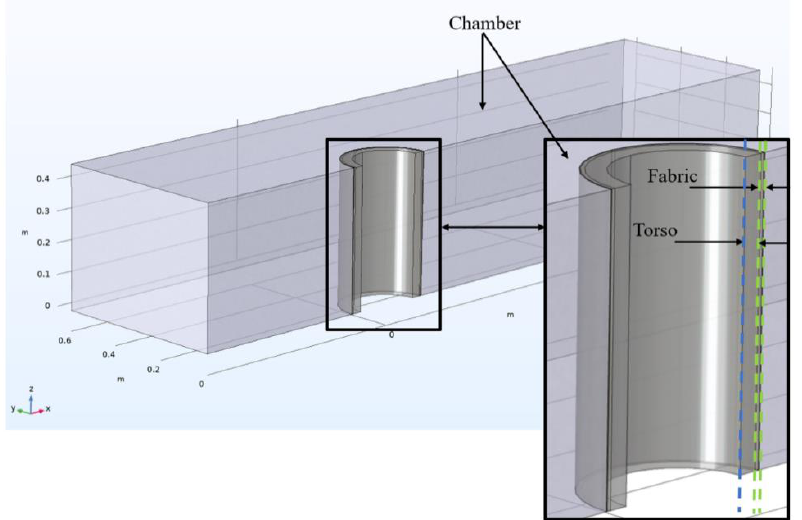
Figure 2. Geometry of the model representing an upright cylindrical apparatus simulating the human trunk in a climatic chamber.